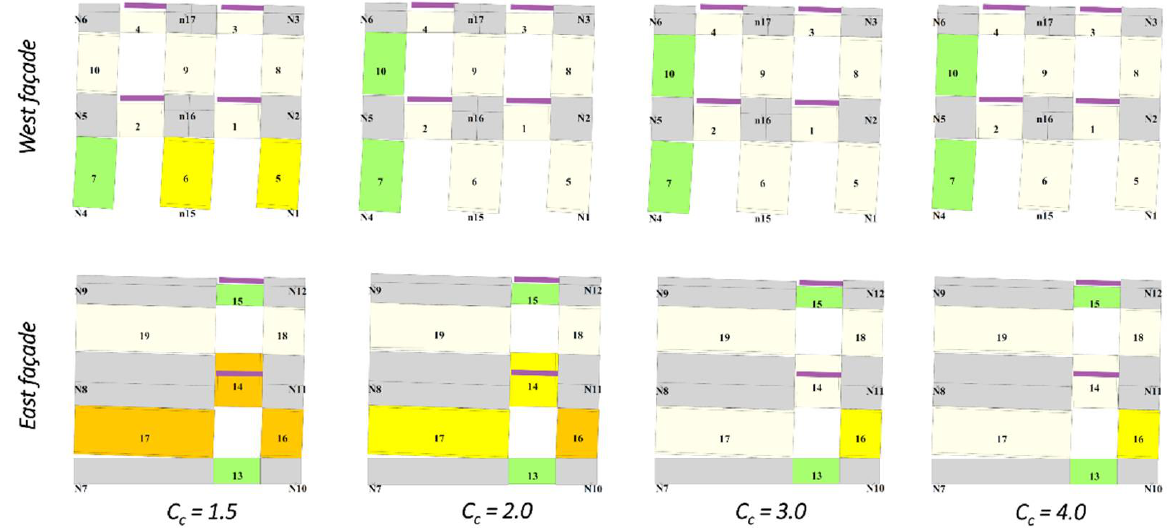
Figure 18. Comparison between damage patterns obtained with various correction coefficients for Building 3 neglecting any masonry tensile strength (with magnified lateral displacements).